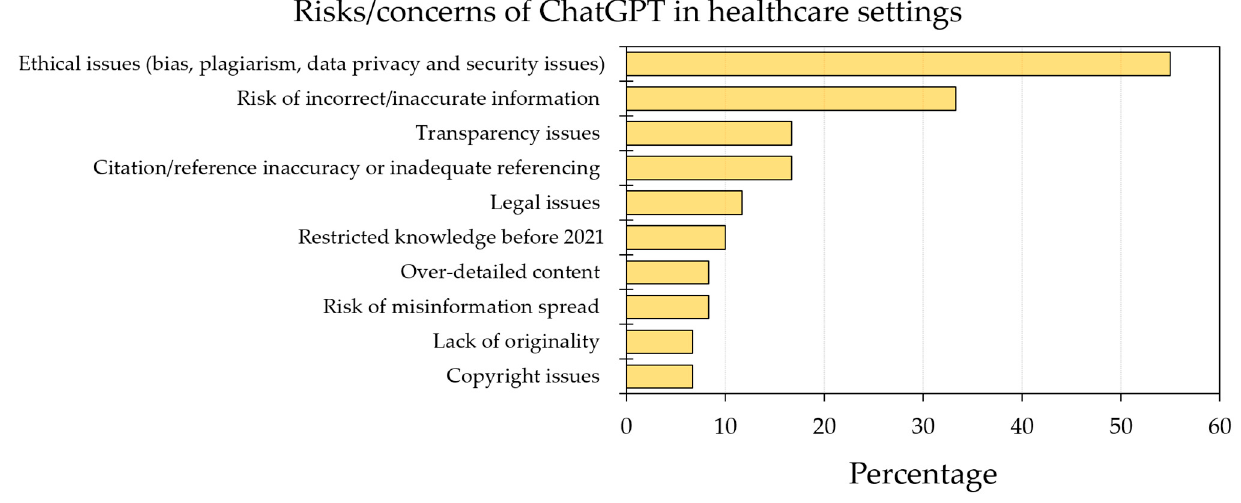
Figure 4. Summary of risks/concerns of ChatGPT use in health care education, research, and practice based on the included